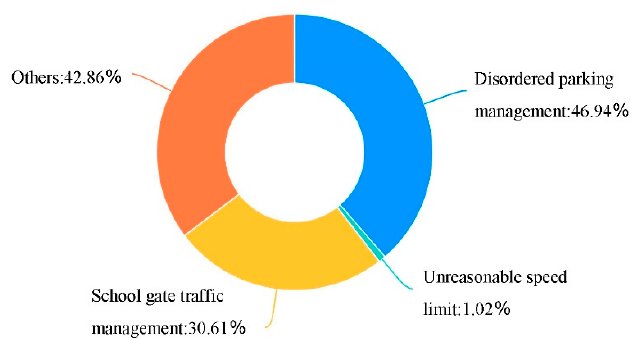
Figure 8. The lack of management of the current school travel road.